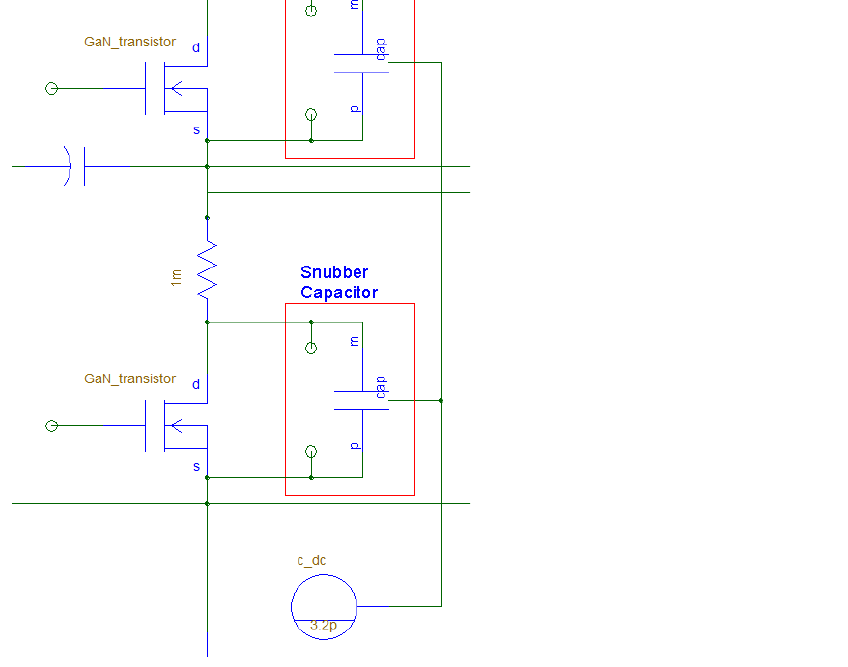
Figure 13. The part of Saber@Sketch schema for determination of the optimal snubber capacitor. After extracting data from the result of the simulation series, the maximum value of voltage across the transistor T 1 can be presented in the function of the snubber capacitance as in Figure 14. The results are similar as presented in [10], where the analytical formula was